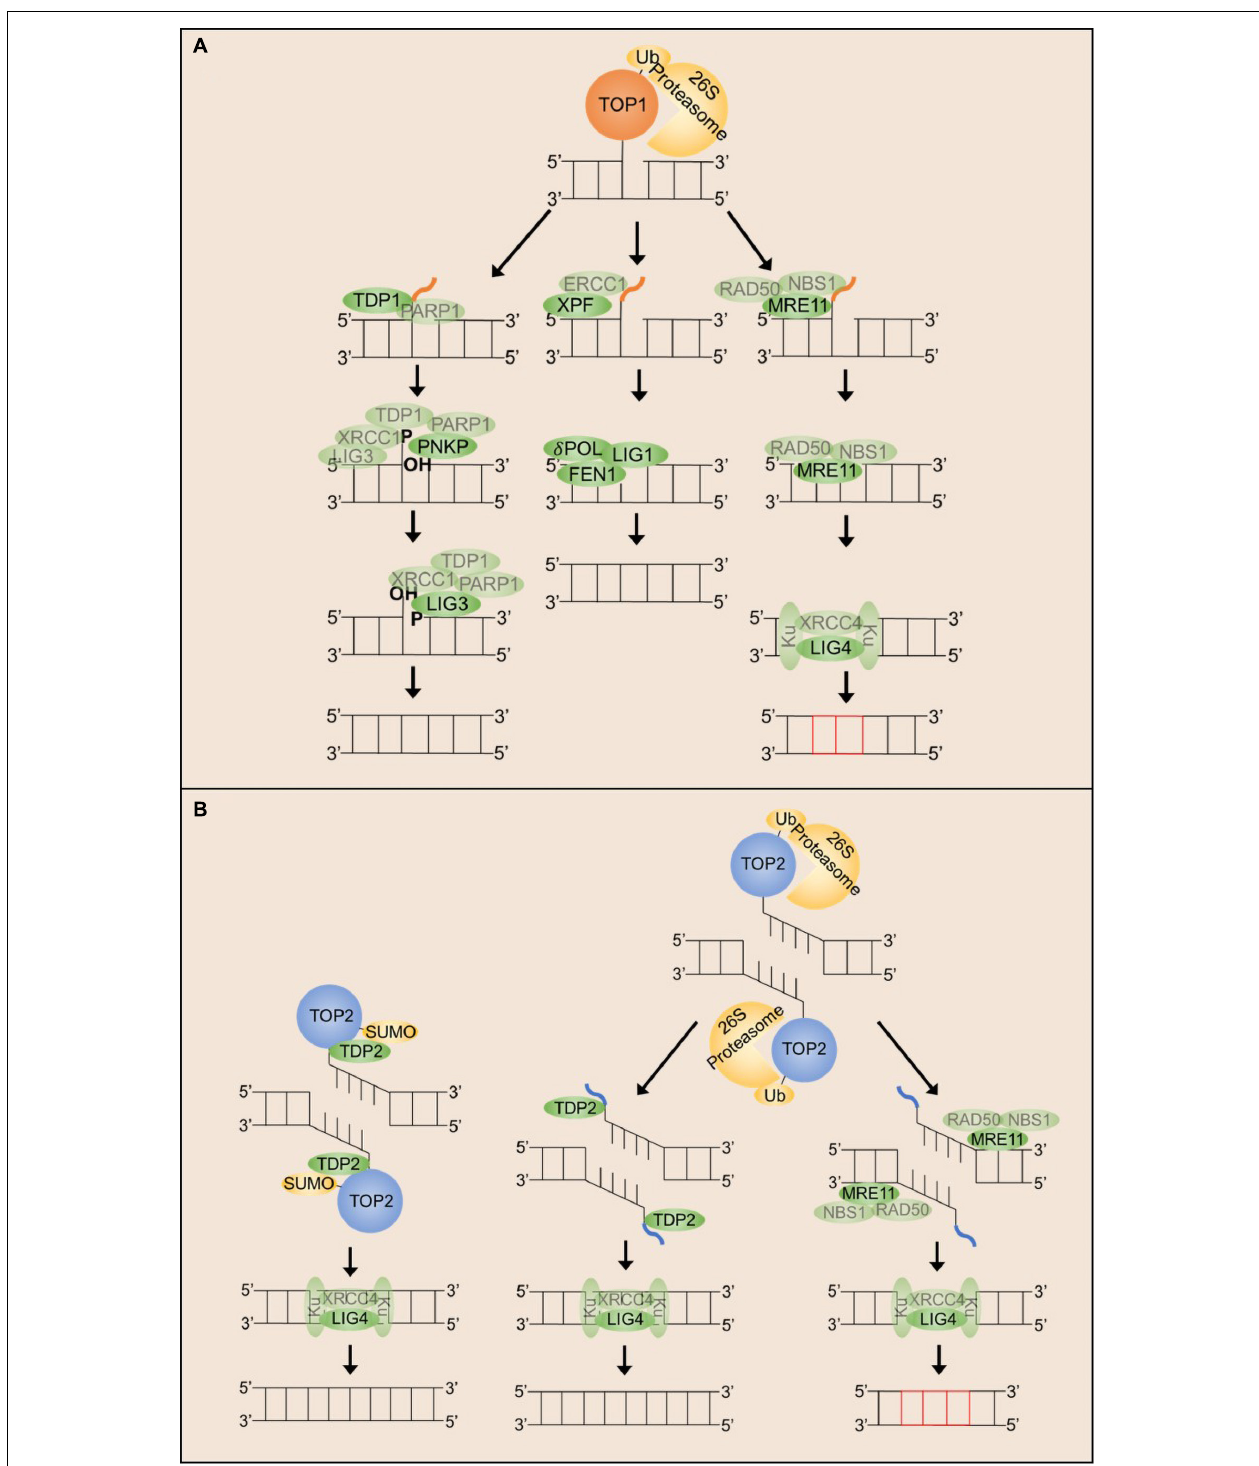
FIGURE 2 | Mechanisms that can repair stalled TOP1 and TOP2 cleavage complexes in post-mitotic neurons. (A) TOP1ccs can be resolved by either TDP1, XPF/ERCC1 or MRN dependent mechanisms. Each of these mechanisms appear to require proteasomal degradation of the TOP1 adduct. (B) TOP2ccs can be resolved either by TDP2 or by MRN dependent mechanisms. Each of these mechanisms can be utilized following proteasomal degradation of the TOP2 adduct, but TDP2 can also facilitate direct hydrolysis of the phospho-tyrosyl bond.